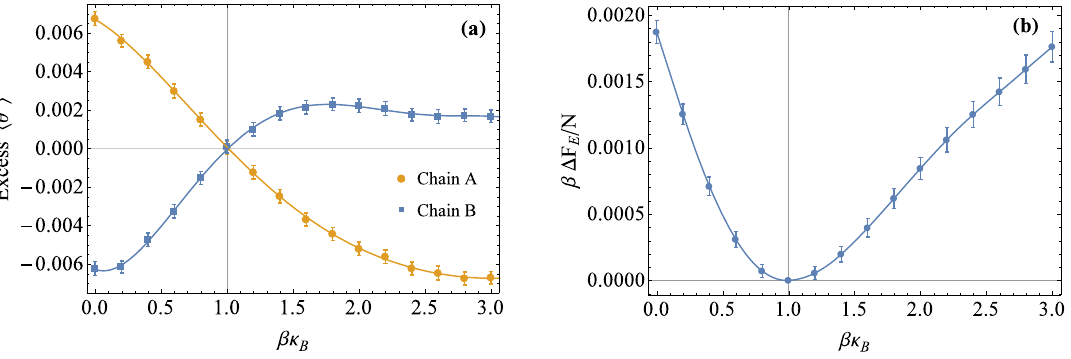
Figure 5. ( a ) Excess (cid:104) θ 2 (cid:105) in radians as a function of βκ for simulations with a reference chain of stiffness βκ A = 1. The error shown was calculated from the autocorrelation time. ( b ) β ∆ F E / N determined via integration of excess (cid:104) θ 2 (cid:105) . ∆ F E is zero by definition where the reference and variable chain stiffnesses are equal at βκ =